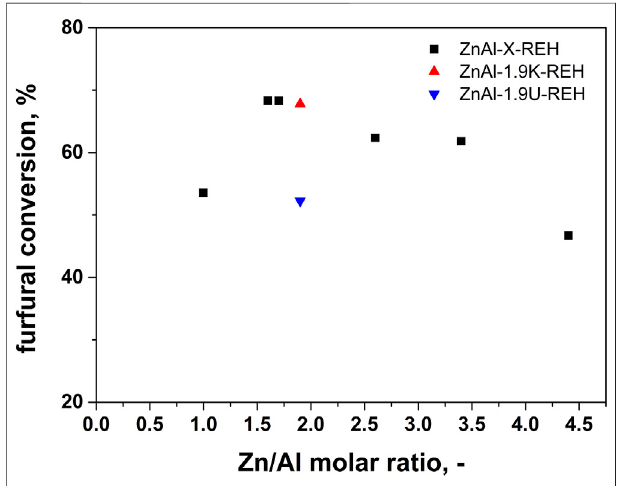
FIGURE 11 | Dependence of furfural conversion on Zn/Al molar ratio in aldol condensation reaction using ZnAl reconstructed LDHs catalysts.